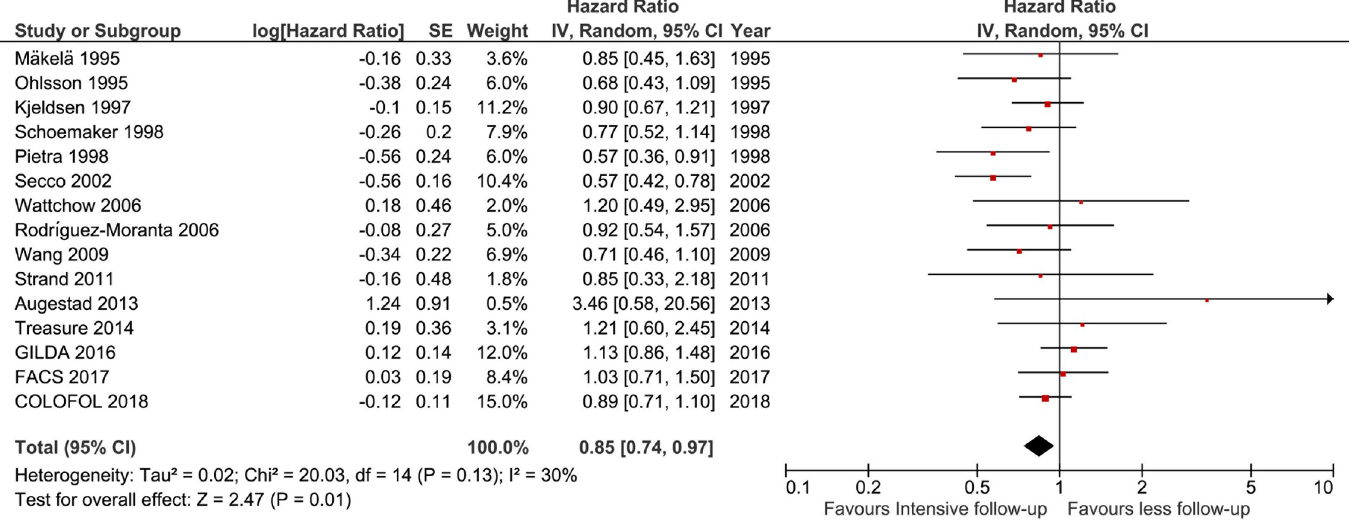
Fig 2. Forest plot of overall survival of all trials. df = degrees of freedom, M-H = Mantel-Haenszel.